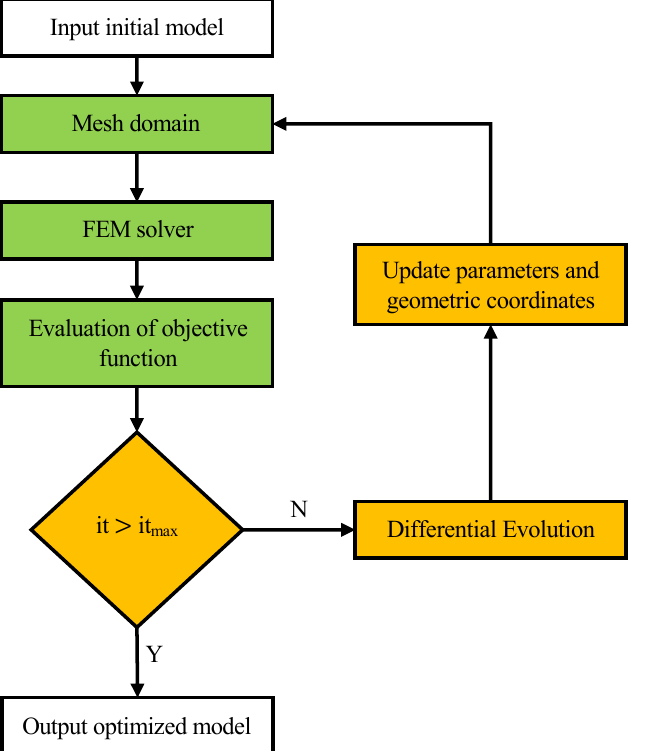
Figure 9. Flowchart of optimization algorithm. Green boxes represent COMSOL ® procedures while orange boxes are performed in MATLAB ®